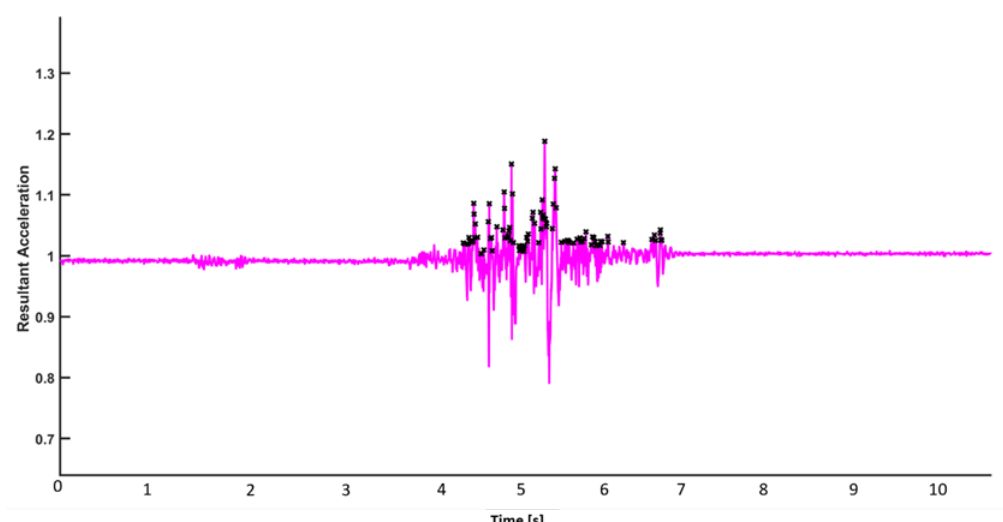
Figure 2. Representative figure for the identification of local maxima.